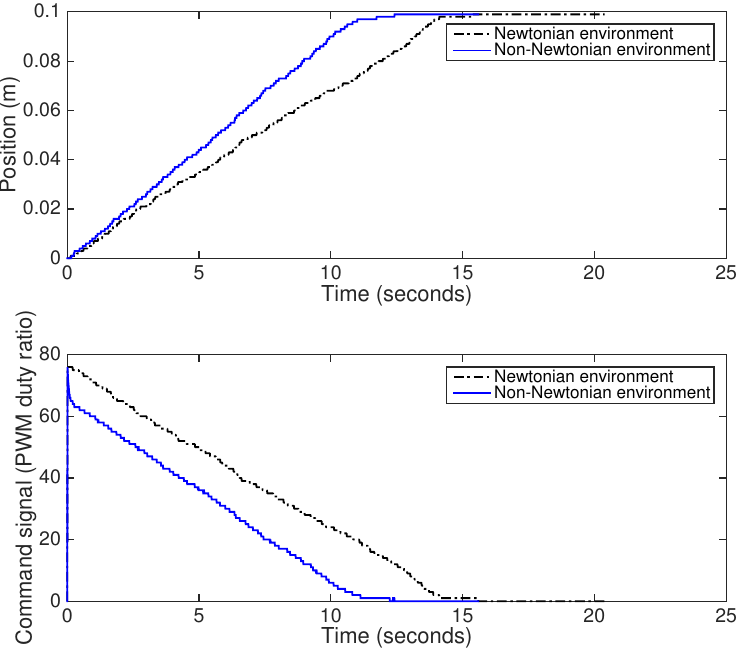
Figure 8. Fractional order PD controller experimental robustness validation in Newtonian and non-Newtonian operating